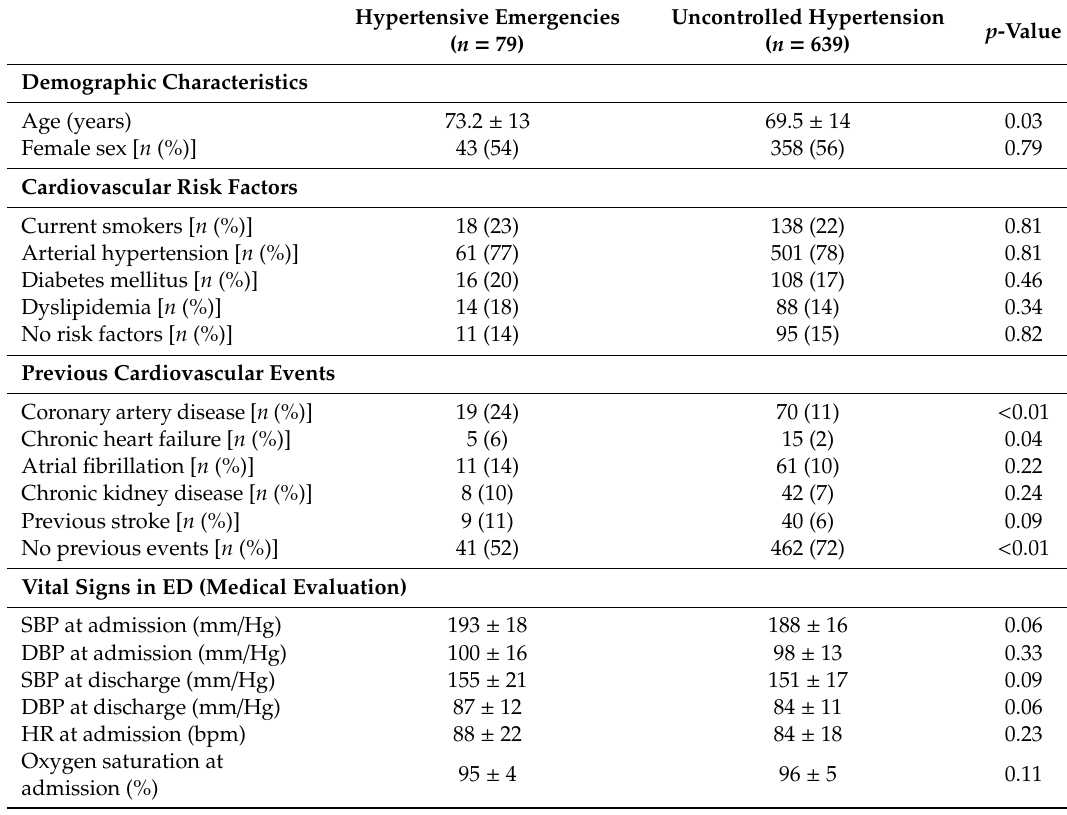
Table 1. Demographic and clinical